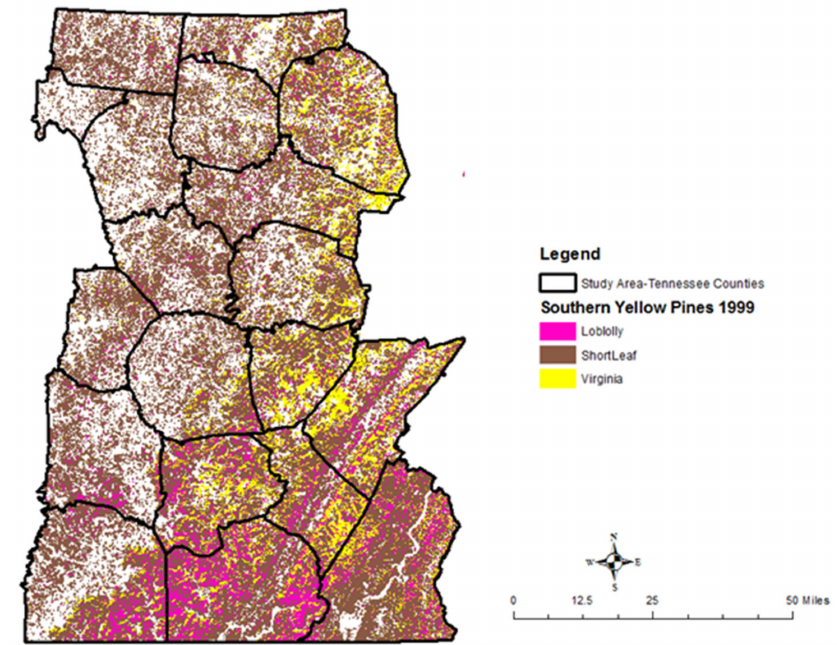
Figure 3. Classified southern yellow pines in February 2016.